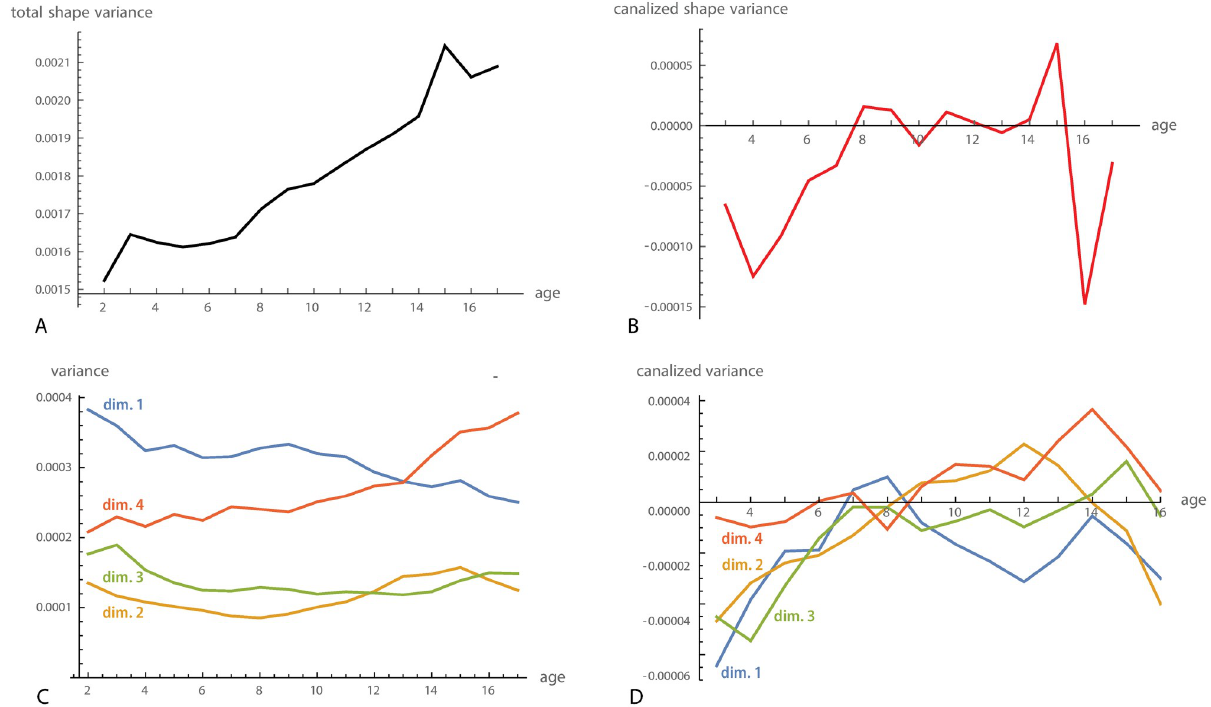
Fig 7. Canalization of craniofacial shape. (A) Total craniofacial shape variance from 2 to 17 years of age. (B) Total canalized shape variance, approximated by 1 : 5 Tr ð cov ð x � ; x � (cid:0) x � ÞÞ : (C) Variance of the first four dimensions of the two-block partial least squares (PLS) analysis between t t þ 1 t craniofacial shape at age 2 and the shape changes from age 2 to 3 (see Fig 8). In other words, these are the cross-sectional variances of the shape features with maximal canalized variance from age 2 to 3. (D) Approximated canalized variance of these four PLS dimensions. The first dimension (blue curve) shows canalization until 6 years and again from 9 to 13, leading to a reduction of cross-sectional variance throughout postnatal development. Dimensions 2 and 3 only show canalization until 6 years of age, whereas dimension 4 shows no signs of canalization (individual differences were even amplified rather than reduced).